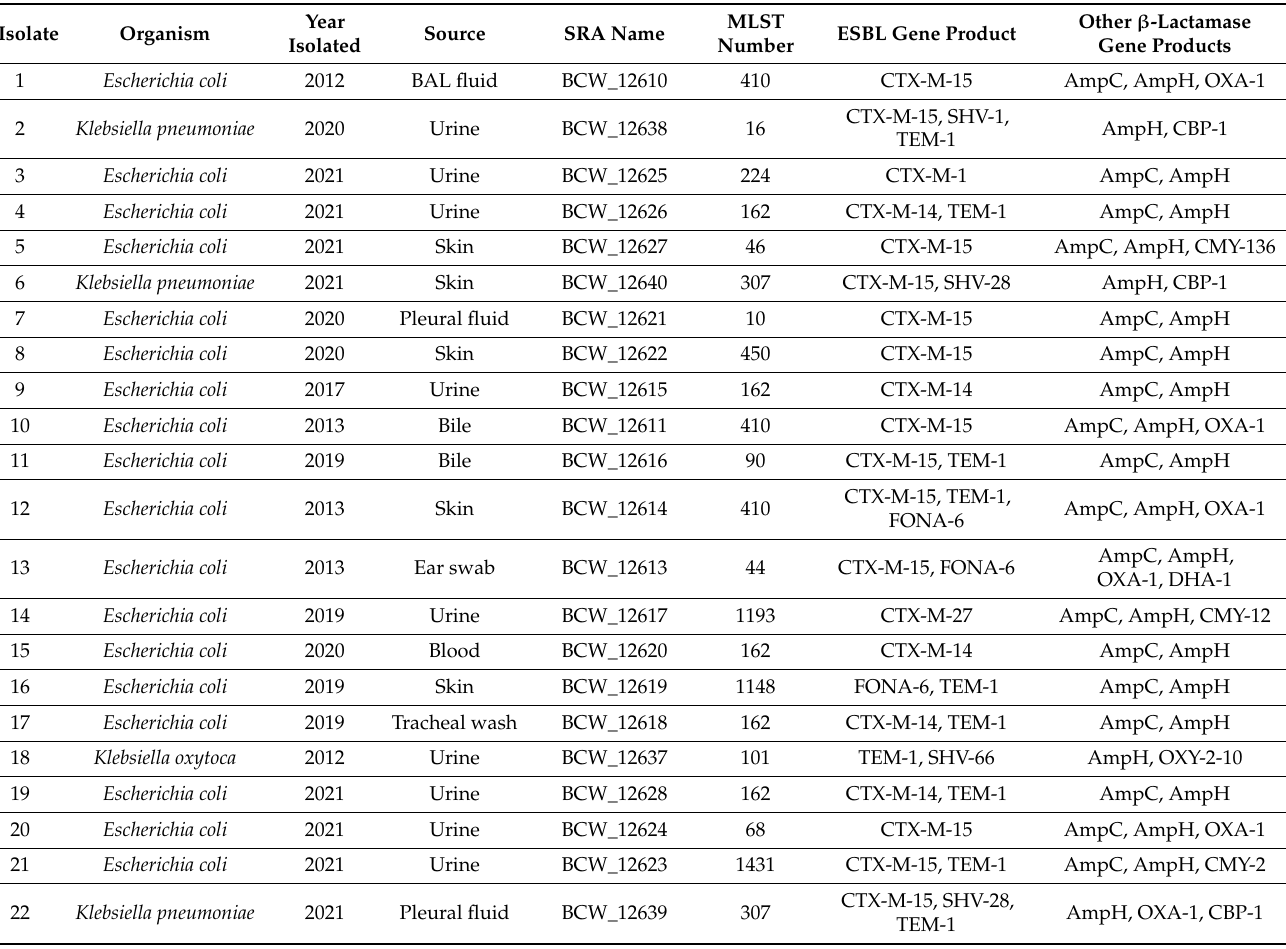
Table 1. Beta-lactamase genes identified in each isolate after whole-genome